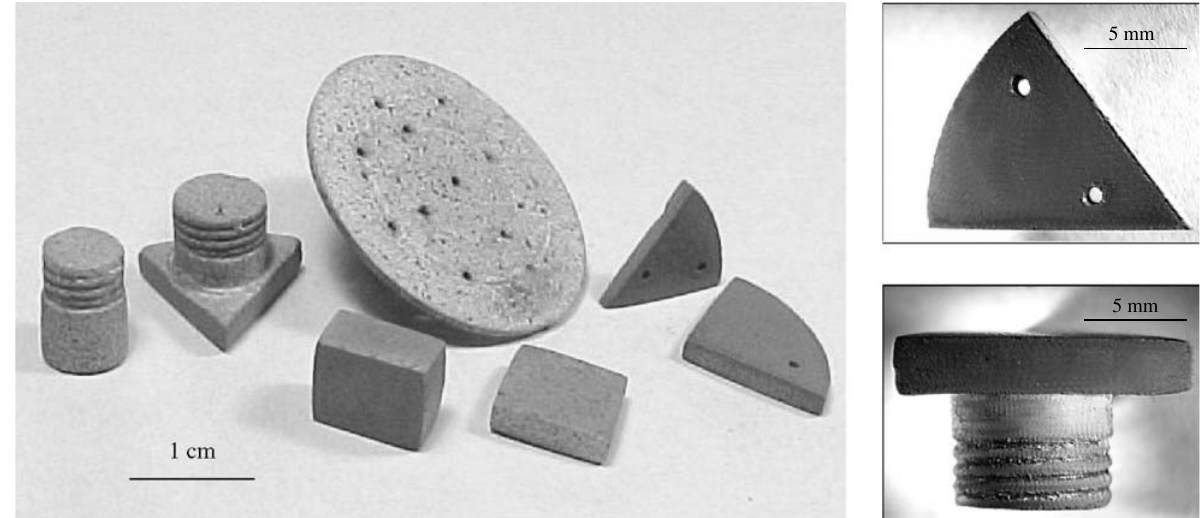
Figure 1. Samples obtained from the AFCOP. Samples were cut, drilled, machined and then pyrolysed at 1500 °C/2 h.